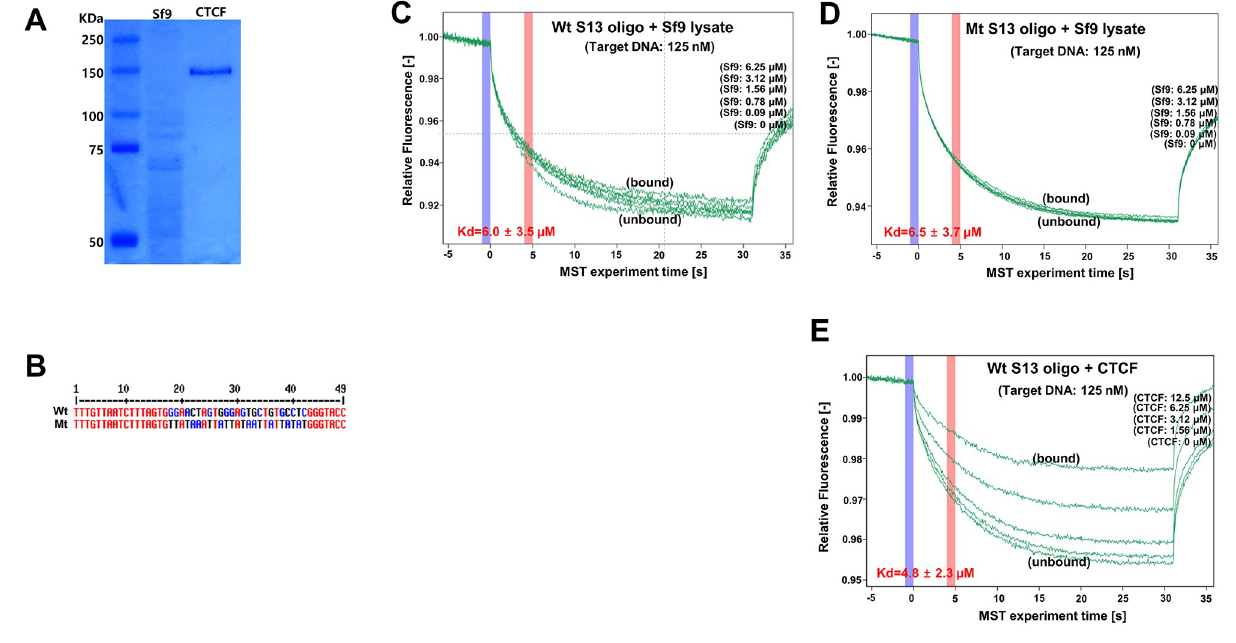
Fig 2. Detection of CTCF-DNA interaction using the Monolith NT.115. A) Quality confirmation of purified CTCF protein by Coomassie blue staining. CTCF was purified using Sf9 baculovirus protein expression system. B) S13 5’ FAM labeled 49-mer primer whose sequence was mutated (Mt S13 primer sets) or not (Wt S13 primer sets). Wt S13 locus used in this study was designed from EBV 138946 ~ 138994 (NC_007605), and Mt S13 locus was constructed by introducing site-directed mutations into EBV 138963 ~ 138978. C-E) CTCF-DNA interaction tested by Microscale thermophoresis (MST) assay. Wild-type (Wt) and mutant (Mt) S13 5’ FAM labeled 49-mer primer sets were paired to convert double DNA fragments. MST assays for determining CTCF binding to Wt and Mt S13 DNA fragments were conducted using 125 nM DNA fragments and a series of concentration of